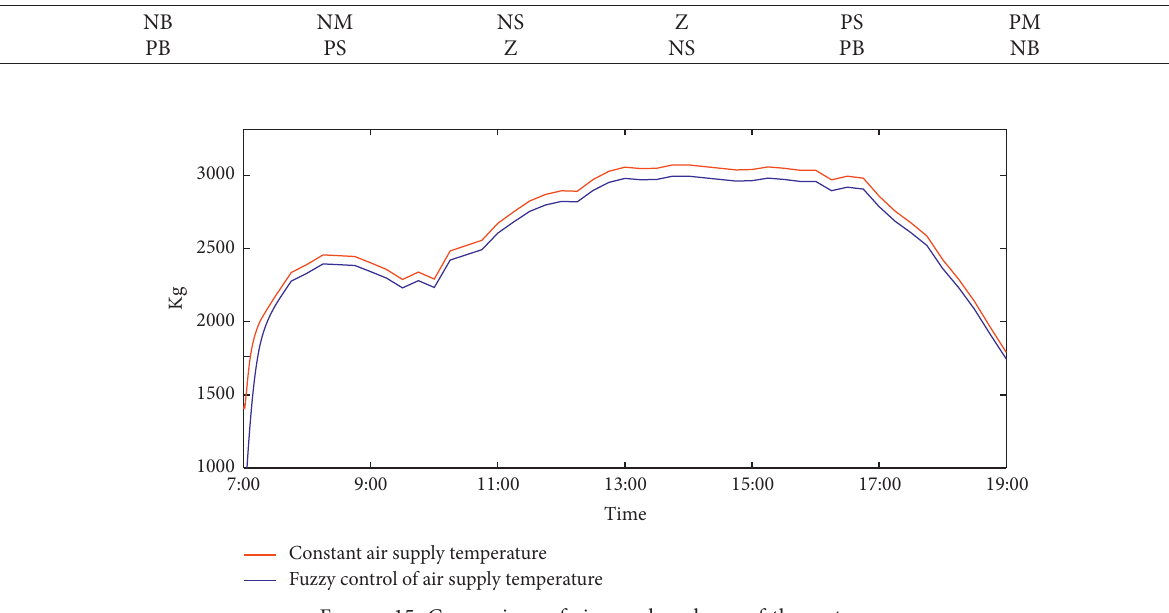
Table 2: Fuzzy control rule table of supply air temperature